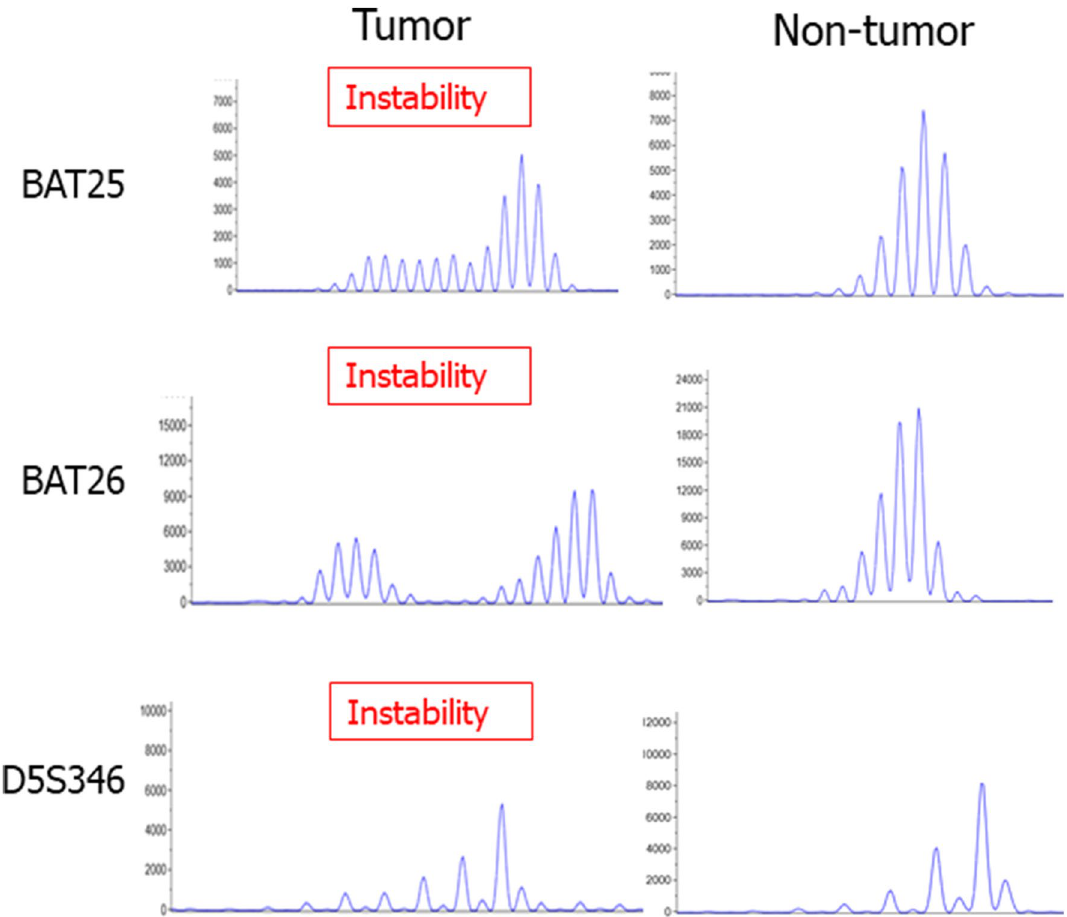
Figure 4. Microsatellite instability analysis. Two out of three NTRK1 fusion CRCs showed microsatellite instability for 3 out of 5 markers. Additional peaks were observed only in the tumor-derived DNA samples for all three